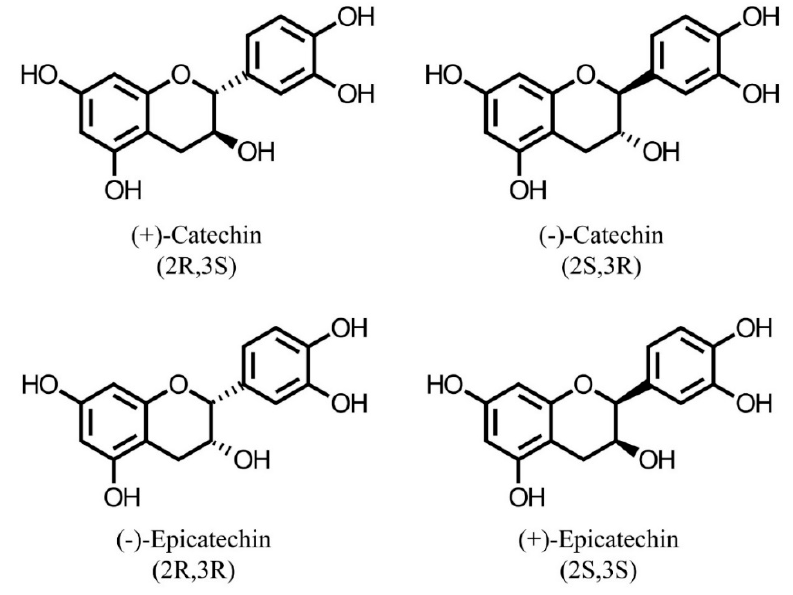
Figure 2. Chemical structures of isomers of monomeric units of procyanidins.